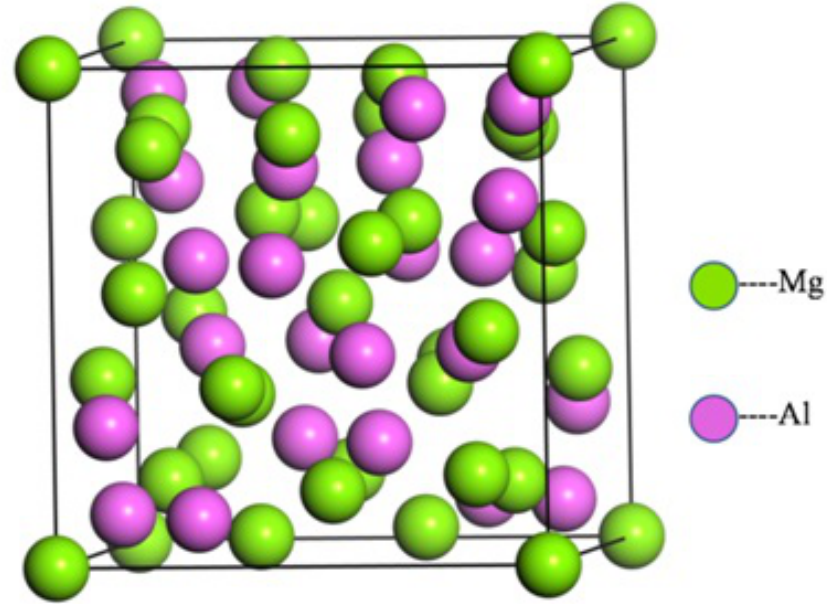
Figure 1. The cubic crystal structure of the β -Mg 17 Al 12